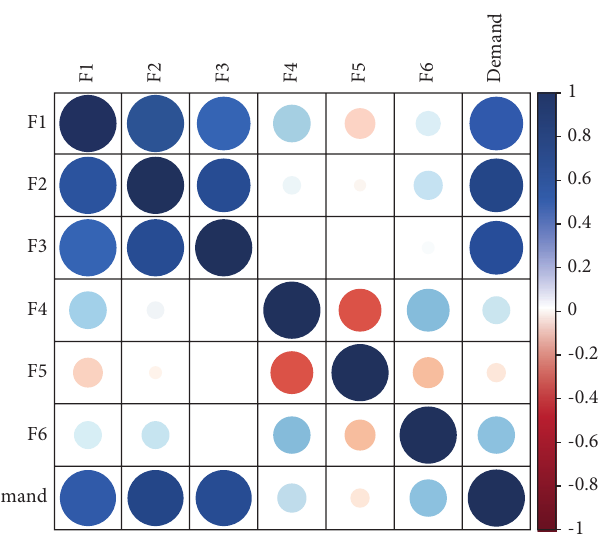
Figure 2: Correlation matrix for all influence features corresponding to the demand. Table 4: Summary of all extensive experiments to select the best performing preprocessing feature selection methods with the number of features and regression